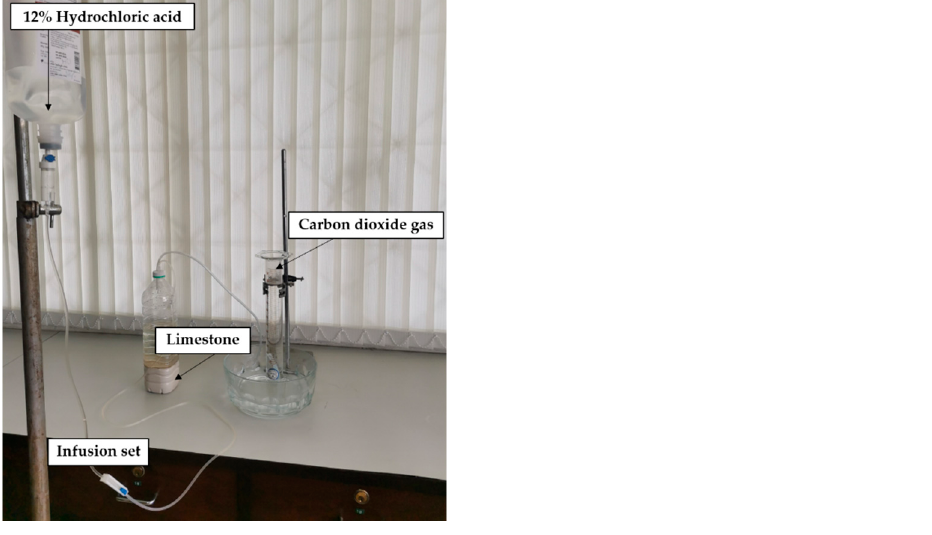
Figure 2. Determination of CO 2 flow from limestone reacted with continuous dripping of acid solu- tion. Table 1. Amount of CO 2 gas produced by the reaction between 1 g of limestone and excess acid solution, compared with 1 g of calcium carbonate.